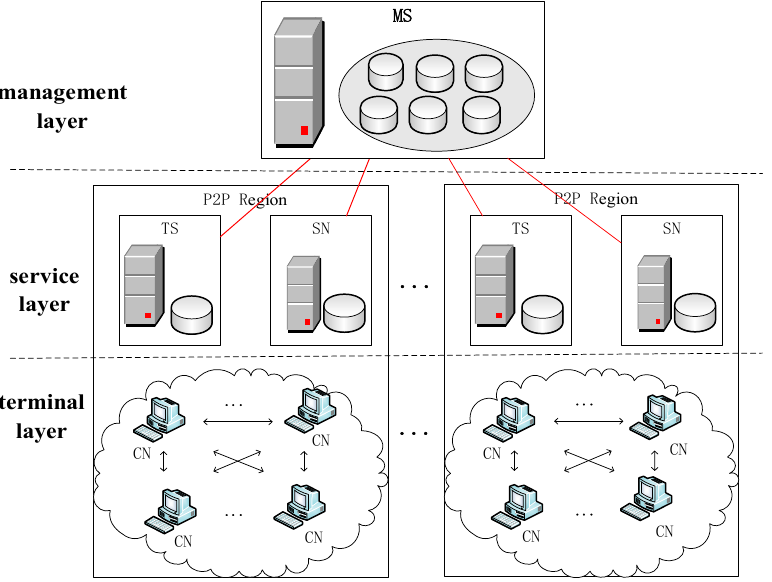
Figure 1. Architecture of the peer-to-peer (P2P)-based video-on-demand (VoD) system.